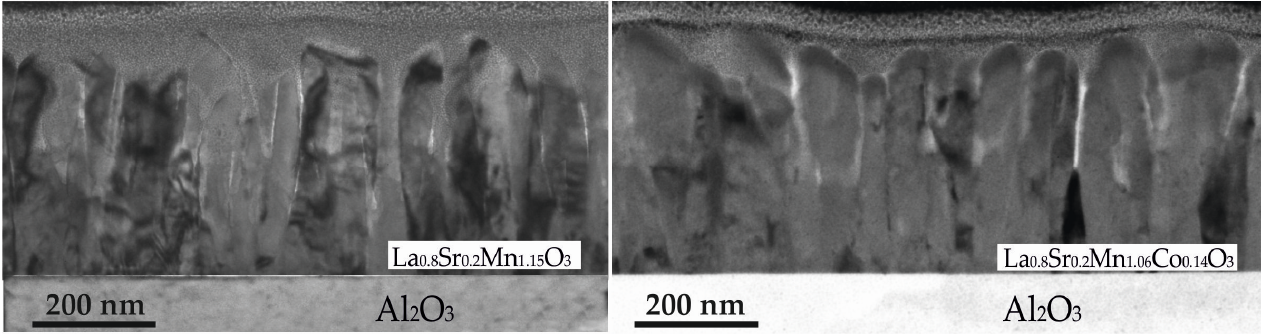
Figure 1. TEM images of the film with different chemical composition. For the electric transport and magnetoresistance (MR) measurements, two Ag elec- trodes with a Cr sublayer were thermally deposited and post-annealed at 450 ◦ C for 1 h in Ar